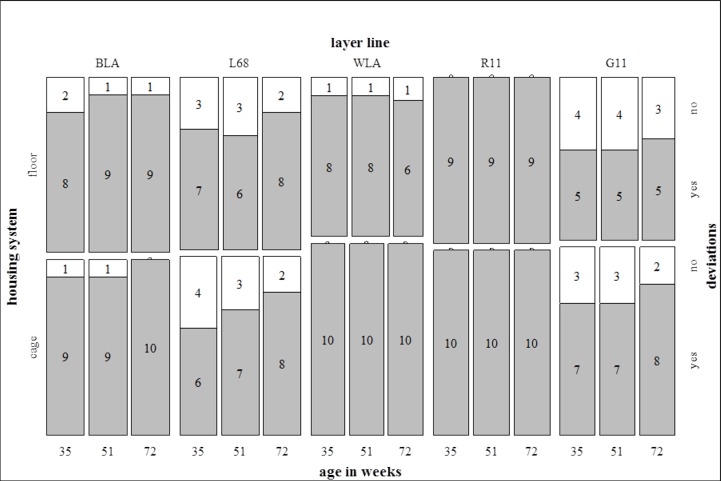
Prevalence of deviations.Each bar represents the total amount of radiographed and evaluated hens of one layer line within one housing system. The grey part of a bar shows the part of hens with a deviated keel bone, the white part those without any deviation. The numbers written in the bars show the total numbers of affected or non-affected hens, respectively. Prevalence of deviations was affected by layer line (p<0.05). There was no significant influence of housing system (p>0.05) or age (p>0.05) on prevalence of deviations.